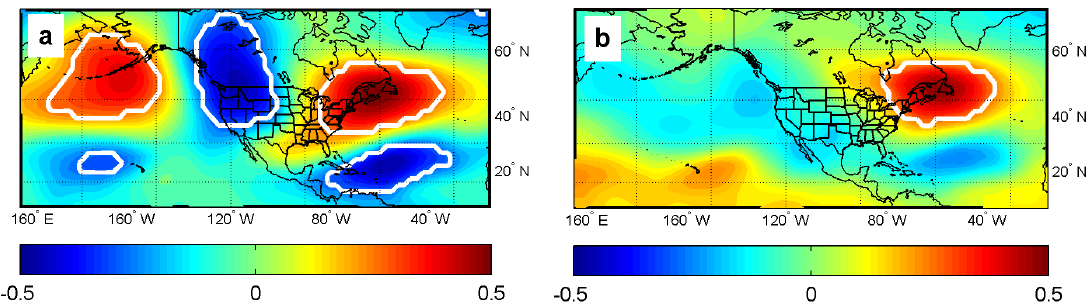
Figure 11. Correlations between 500-mb height anomalies and ( a ) the actual Michigan-Huron wintertime lake-level changes (20-y moving average removed), and ( b ) the residual lake-level changes after accounting for the PNA signal. Statistically significant correlations ( p < 0.05) are encompassed by the white